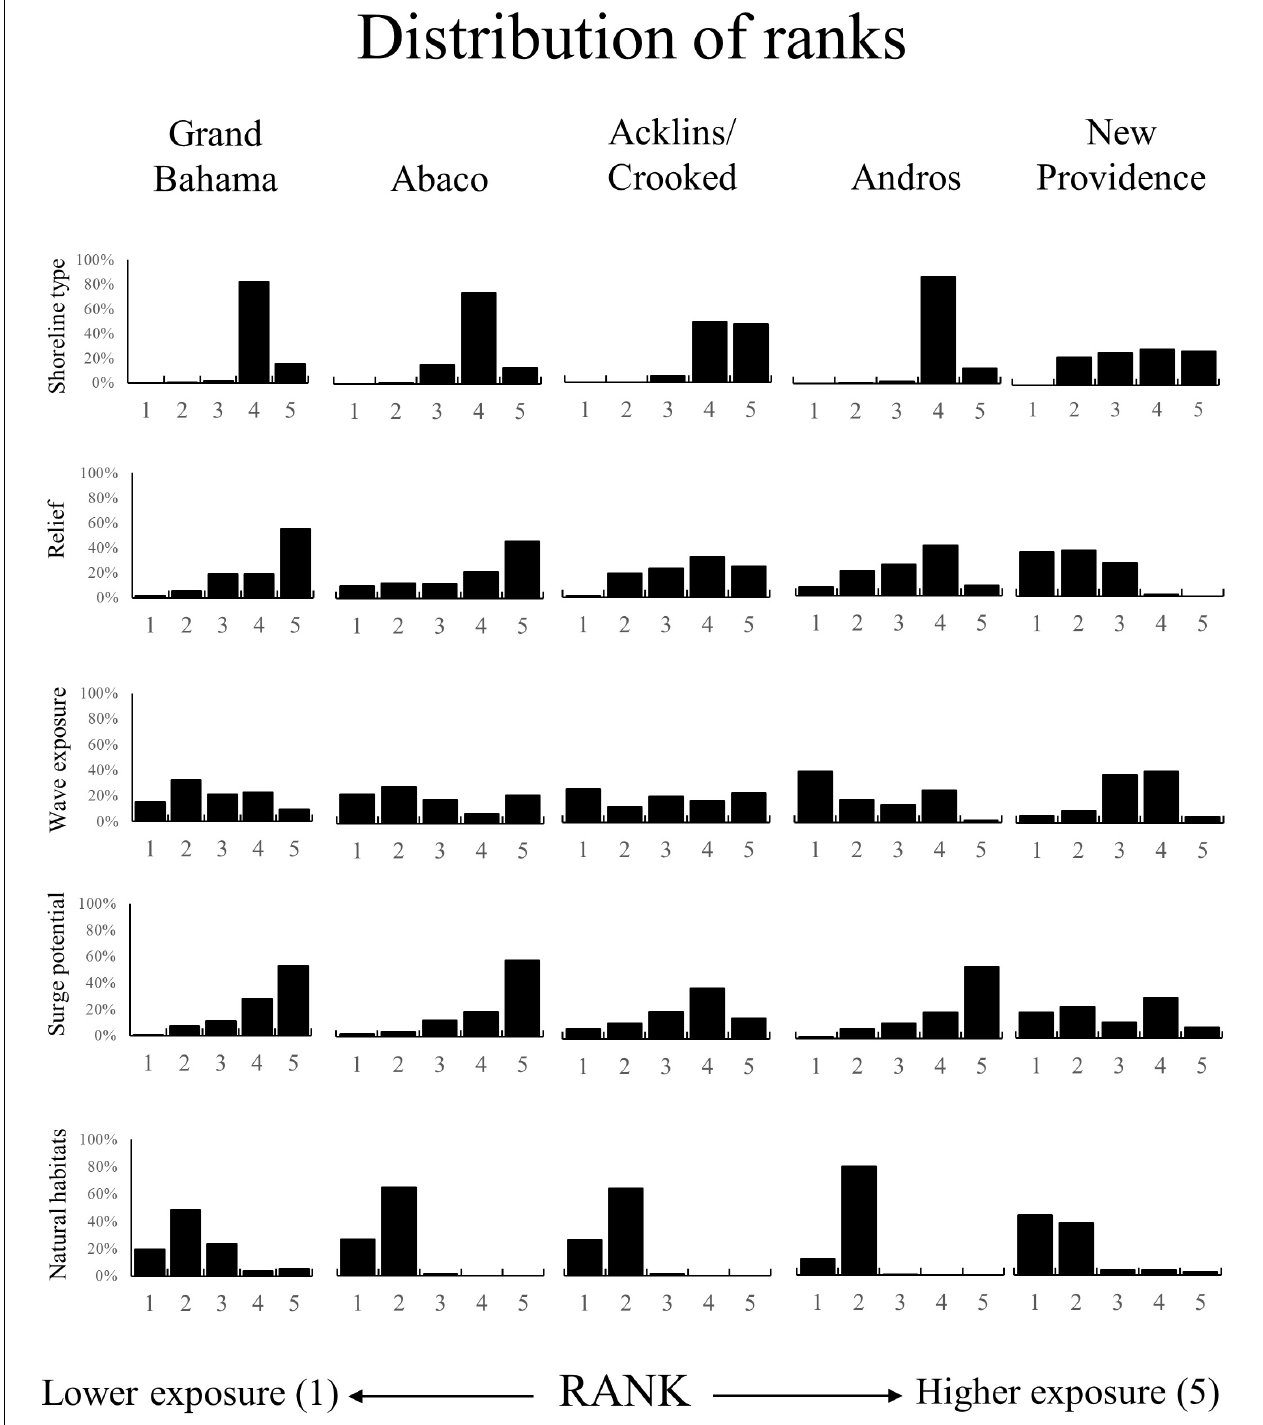
FIGURE 3 | Distribution of ranks for individual variables in the coastal hazard index for each 250 m coastal segment for the islands in The Bahamas with the greatest proportion of highly exposed coastline. A rank of “1” contributes to lowest exposure, while a rank of “5” contributes to highest exposure. These distributions of ranks for individual variables in the coastal hazard index reveal key drivers of exposure across the region. For example, wave exposure ranks are distributed relatively uniformly (from 1 to 5) across each island indicating that this variable may be less critical in influencing differences in exposure among these five islands. However, the shoreline type and surge potential variables are skewed toward higher ranks, indicating that these are important variables driving the relatively high exposure on these islands.